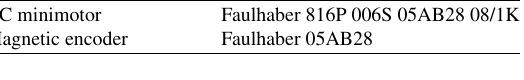
Table 3 Haptic master components